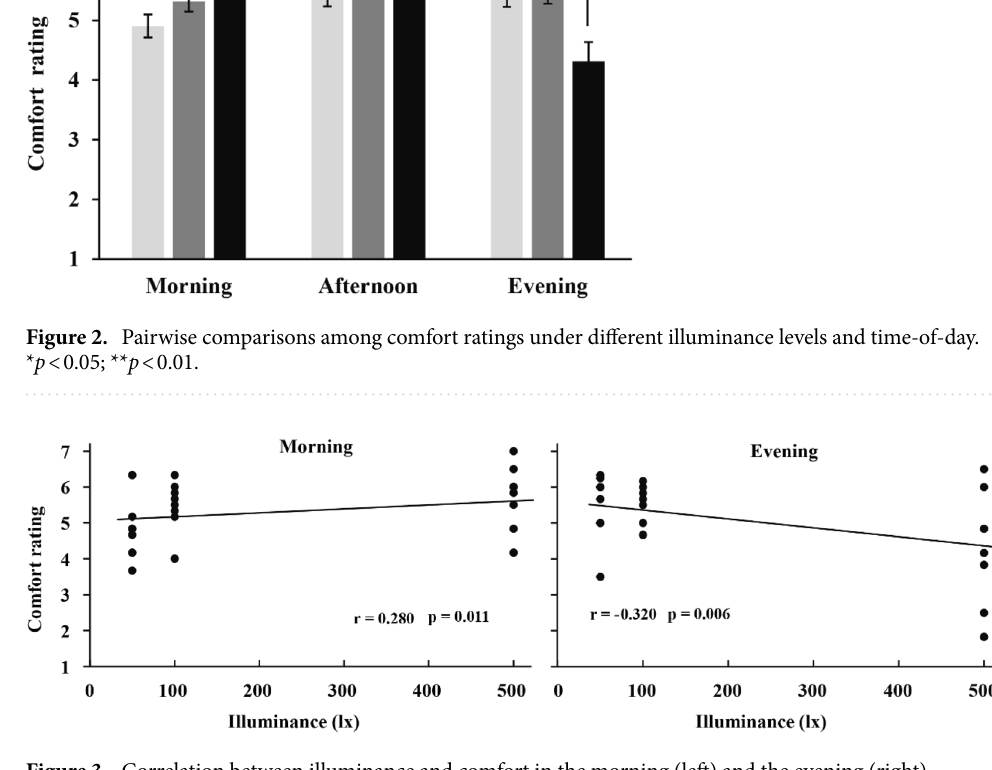
Figure 3. Correlation between illuminance and comfort in the morning (left) and the evening